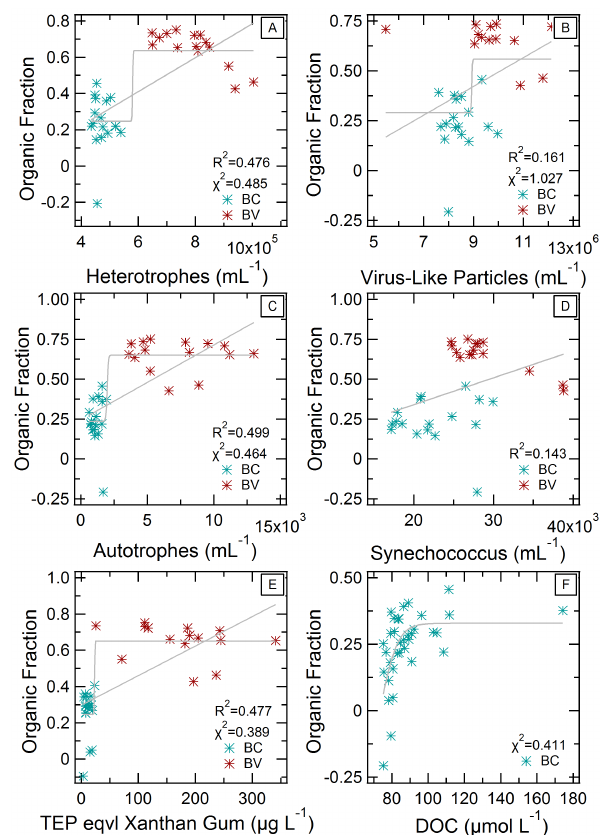
Figure 9. Organic fraction calculated from kappa ( κ org = 0.006 and κ inorg = 1.25) at SS = 0.39% vs. heterotrophic prokaryotes (a) , virus-like particles (b) , autotrophic prokaryotes (c) , and Syne- chococcus (d) abundances, and TEP equivalent (xanthan gum) (e) , and DOC (f) concentrations for all three mesocosms during both BC and BV. Linear fits with R 2 values are shown for all figures ex- cept for (f) , and sigmoid fits with χ 2 values are shown for all panels except for (d)